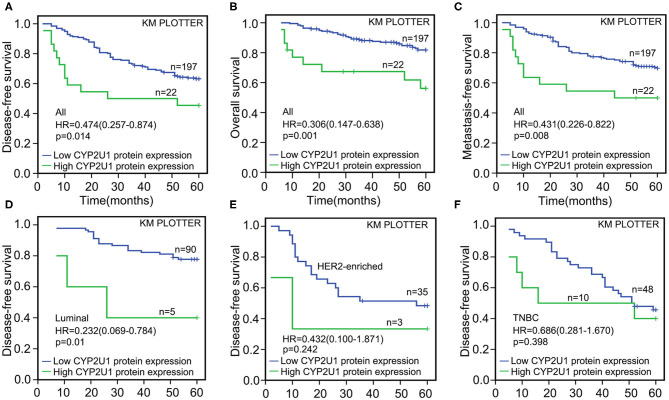
Kaplan-Meier survival curves for the correlation of CYP2U1 protein expression with breast cancer. Kaplan-Meier plotter analysis indicated that higher CYP2U1 protein expression was correlated with worse 5-DFS (A), 5-OS (B), and 5-MFS (C) at whole level, and patients with lower CYP2U1 protein level enjoyed longer time free from tumor recurrence and/or death among luminal subgroup (D). Kaplan–Meier survival analysis of CYP2U1 protein expression was not statistically significant for 5-DFS in HER2 overexpression (E), and TNBC (F) patients.